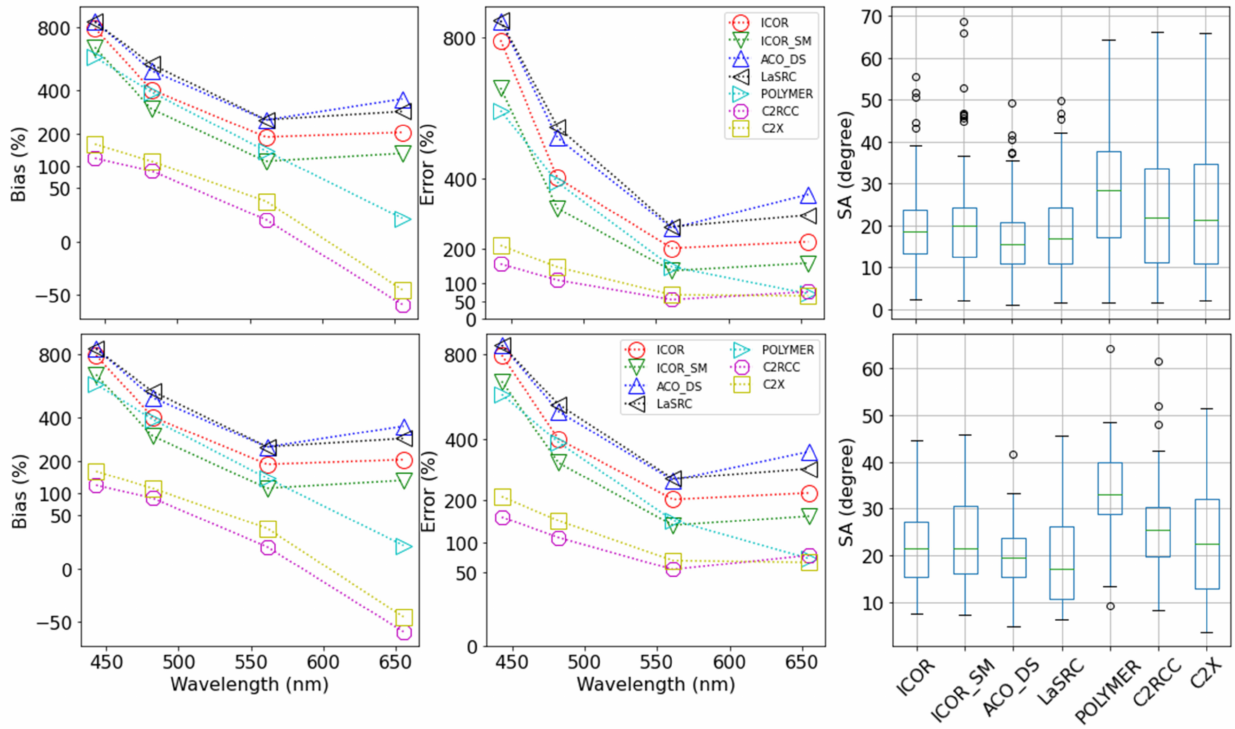
Figure 8. Performance assessment of the processors in terms of median bias (left), errors (middle), and similarity angle (right) for the G-ALL (upper) and G-CIRRUS group (bottom), respectively, for Landsat 8. In the boxplots, the median values are shown as the green lines, and the circles represent the